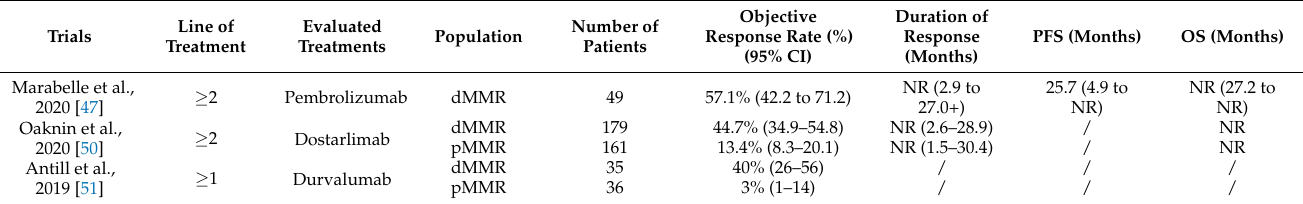
Table 3. Main trials evaluating immunotherapy in MSI endometrial